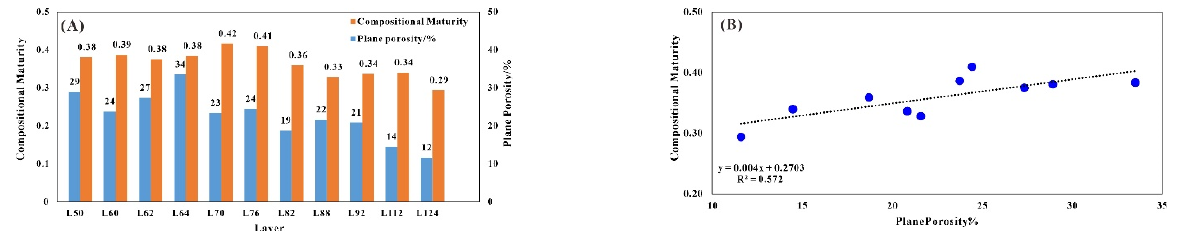
Figure 16. Star diagram shows the mineral distribution characteristics of different sedimentary mi-